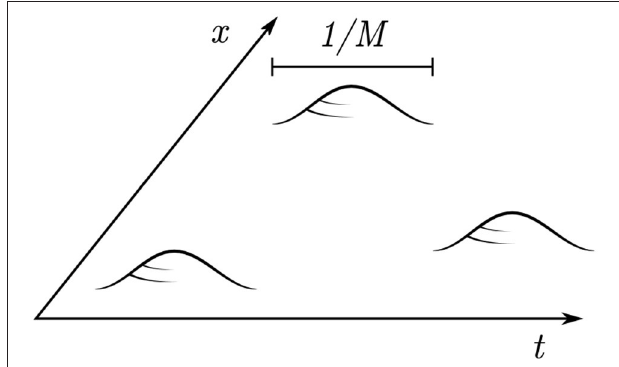
FIGURE 2 | Gauge theory instantons as well-separated, localized lumps of field strength.